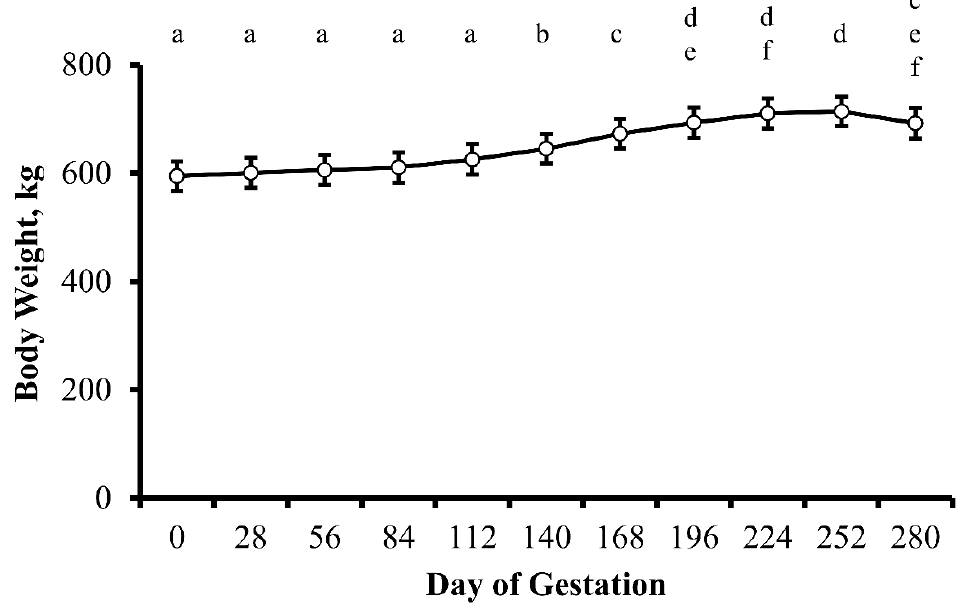
Figure 2. Body weight (kg; least squares means ± SEM) of multiparous cows by day of gestation. Dietary treatments were: Control (0 g urea/animal/day) or Urea (80 g urea/animal/day). Treatments were offered from day 28 of gestation to parturition. Body weight did not change in response to treatment ( p = 0.75) or treatment by day interaction ( p = 0.39). However, BW changed ( p = 0.002) in response to the progression of gestation. a-f Days with different lower case letters are different ( p ≤ 0.04).